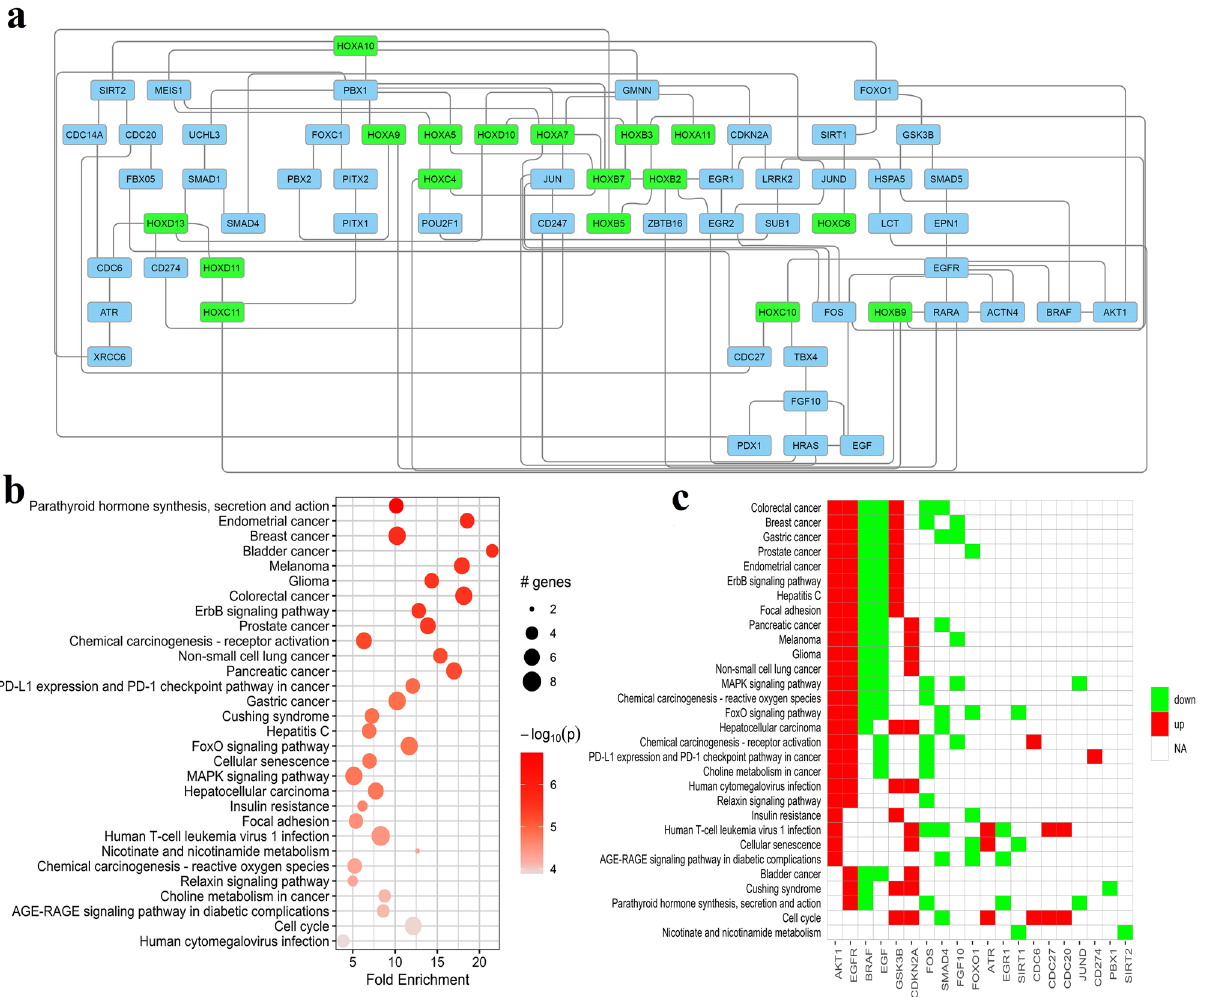
Figure 6. ( a – c ): ( a ) HOX subnetwork analysis depicting the protein interactions of HOX downstream to the key cell cycle regulators ( GMNN , CDKN2A , CDC group of genes), proto-oncogenes such as HRAS , BRAF , JUN and PD-L1 . ( b ) Bubble chart depicting the fold enrichment of HOX associated subnetwork query using the KEGG pathways 26–28 and ( c ) the heatmap illustration of alterations induced by the HOX -interacting proteins as noted in the KEGG pathways. The top 20 hits were displayed. These results implicate that the downstream effects of HOX contribute to the various alterations in the cancer signaling normal regulation patterns during oral cancer disease progression, we selected 19 oral cancer cell lines based on their characteristic features for screening HOX expression patterns in comparison to the patient samples. These analyses are particularly beneficial in identifying a suitable model to study specific HOX or a group of HOX genes. Among the drugs screened to reverse the acquired phenotype, MG-262 (Z-Leu-Leu-Leu-B(OH)2), a pro- teasome inhibitor, was reported to be involved in cell growth arrest by promoting the expression of cell cycle inhibitors (p21 and p27), and by driving cell death through the activation of mitogen-activated protein kinase phosphatase 1 (MAPK1) and c-Jun phosphorylation 50 . Chlorzoxazone, a relaxant, was reported to function in the alteration of Ca 2+ signaling and cell viability by promoting Ca 2+ independent cell death in human oral cancer cells 51 . A study 52 reported that low doses of isotretinoin (13-cis retinoic acid) resulted in the regression of potentially malignant oral lesions. Furosemide, a modulator of cellular pumps, was potentially found to be an effective therapeutic regimen that reverses the multidrug resistance in cancer cells and could be used as an adjunct in cancer therapy 53 . S-Propranolol (PRO), a non-selective beta-adrenergic receptor antagonist (beta- blocker) could be a novel adjunctive treatment for HNSCC as it has been shown to inhibit proliferation, invasion, and angiogenesis, and modulate tumor cell sensitivity 54 . Alvespimycin was reported to function as an antitumor agent which sequestrates the target proteins mediated through HSP90 inhibition directing selective proteasomal degradation of BRAF, a proto-oncogene 55 . GW-8510, also belonging to the class of antineoplastics, acts as a cyclin-dependent kinase inhibitor 56 . These repurposed drugs queried from the CMap dataset could be used as adjuncts of the therapeutic regimen and/or for targeted therapy of HOX genes studied.